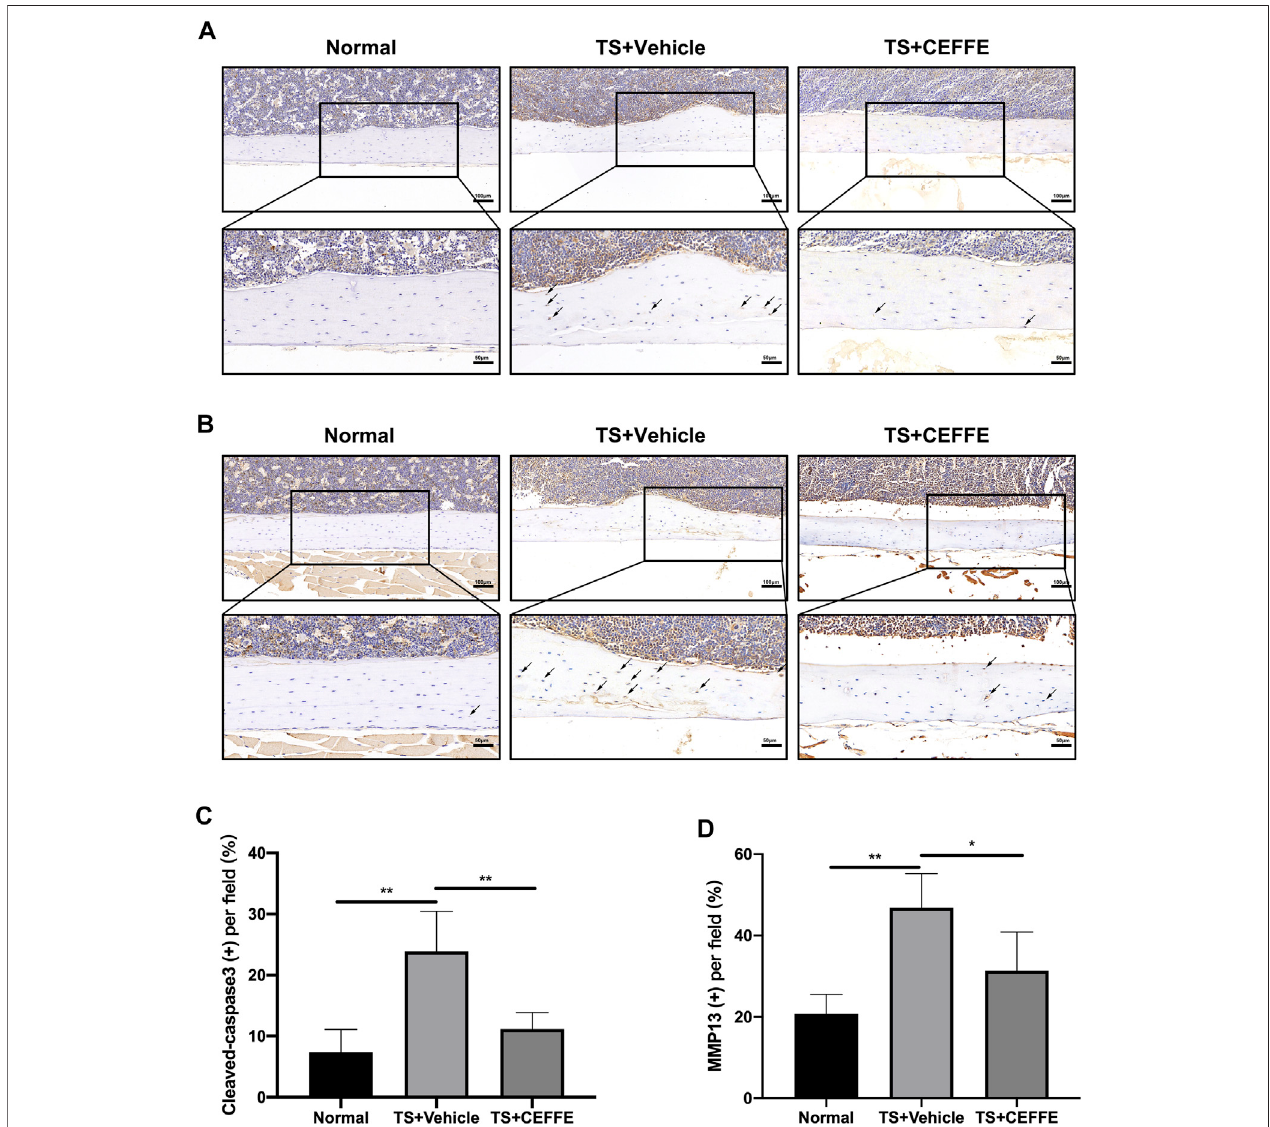
FIGURE 3 | CEFFE attenuated osteocyte apoptosis and extracellular matrix degradation. Immunohistochemical staining and quantitation of femurs shows the expression of cleaved caspase-3 (A,C) and MMP-13 (B,D) . * p < 0.05, ** p <